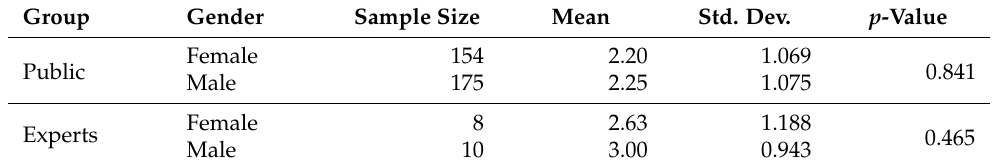
Table 3. Differences in perceptions on wind turbines as a developed technology, grouped by gender. Group Gender Sample Size